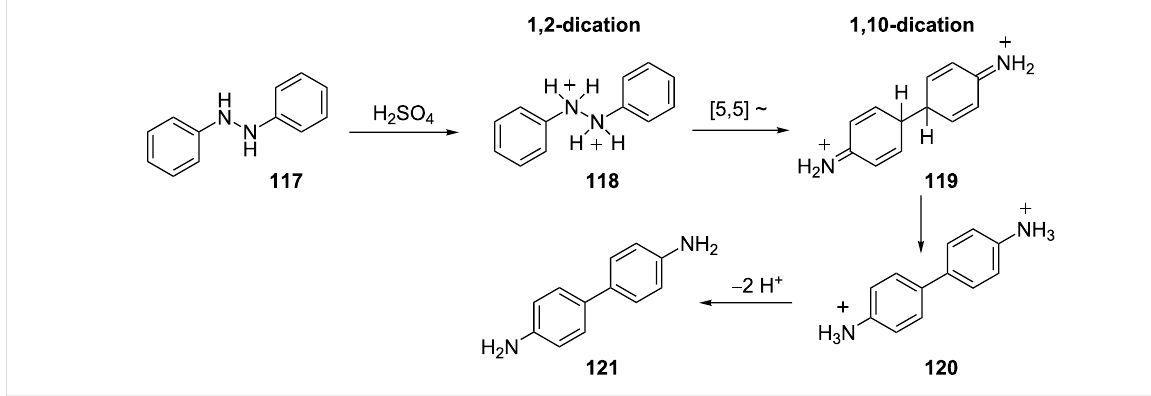
Scheme 24: Proposed mechanism of the benzidine rearrangement.